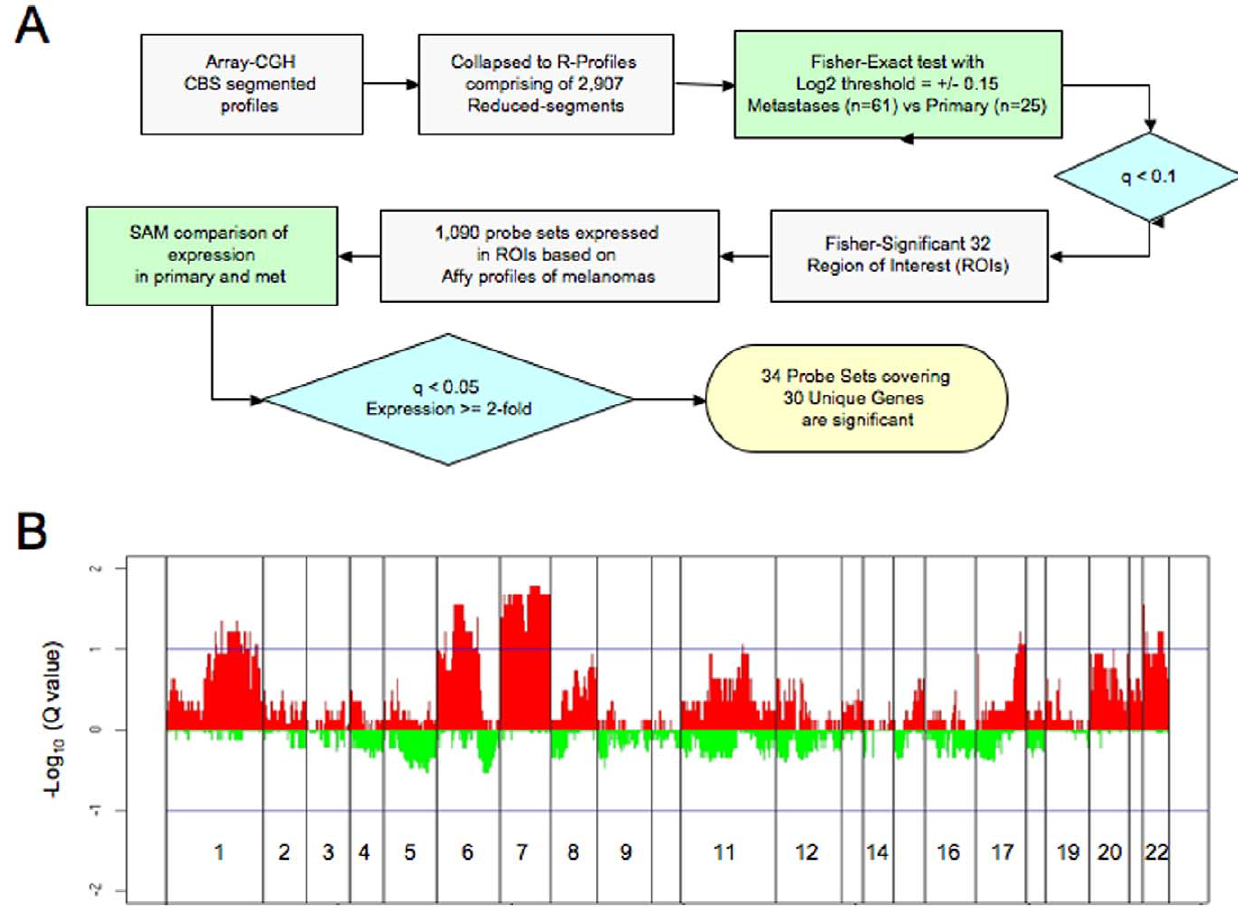
Figure 2. Integrative genomics identify high-confidence metastasis candidate melanoma genes. ( A ) Flow chart of integrating copy number and expression analysis to compare primary and metastastic melanoma genomes. ( B ) Whole genome q-value profiles based on Fisher’s Exact Test between primary and metastastic melanomas. X axis coordinates represent genomic map position and Y axis indicates q-value log10 of Fisher’s Exact Test between primary and metastastic melanomas at each R-segment. doi:10.1371/journal.pone.0010770.g002 PLoS ONE |